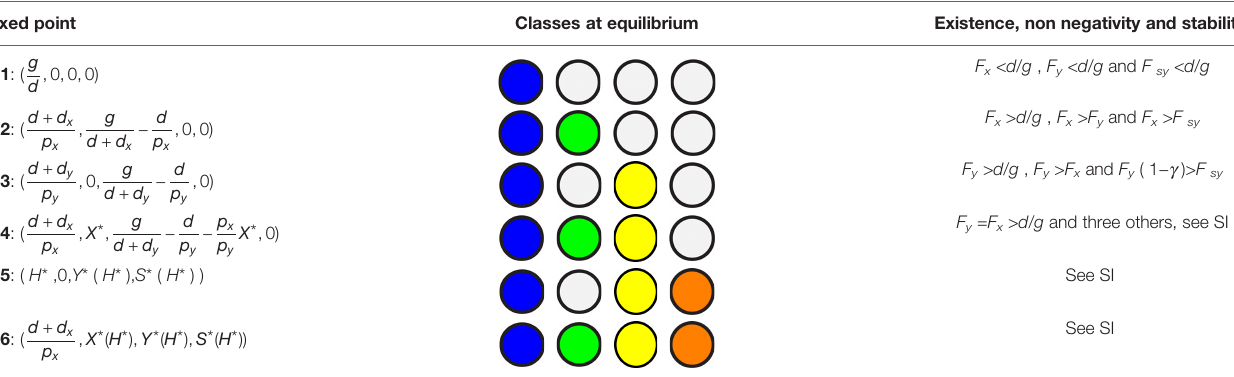
TABLE 2 | Properties of the solutions of model S. Fixed